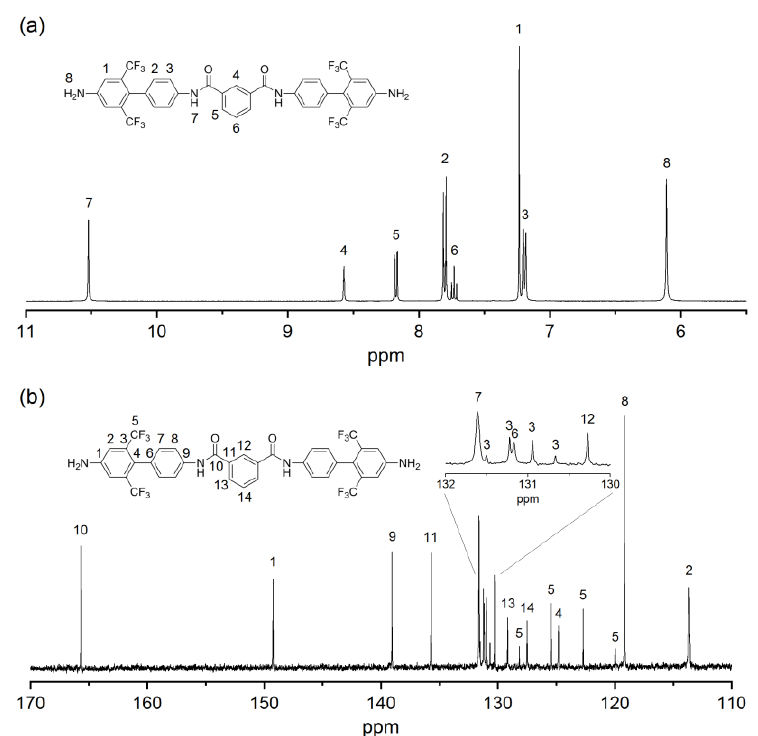
Figure 1. ( a ) 1 H and ( b ) 13 C NMR spectra of diamide-diamine 3 (DMSO- d 6 , 25 °C).